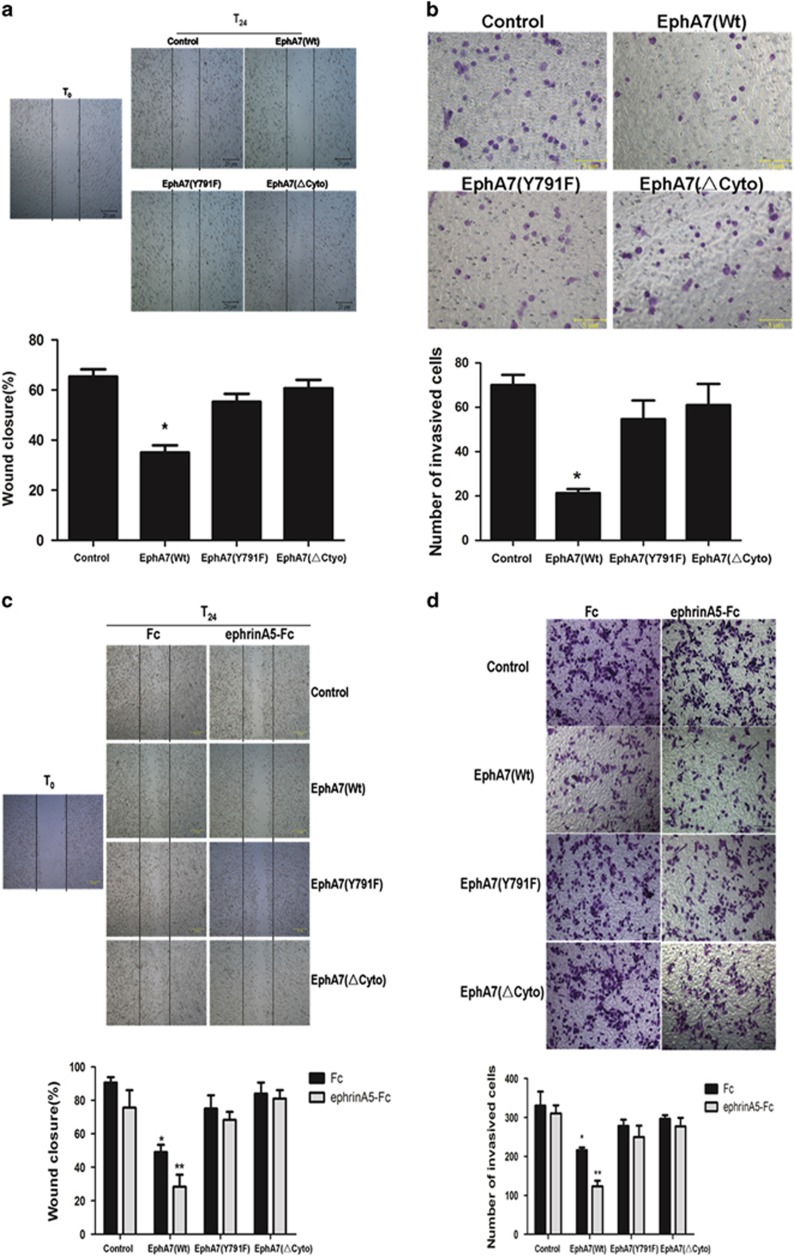
Ligand-dependent inhibition of cell migration and invasion by EphA7 in PCa. (a) DU145 cell migration activity was measured using the wound healing assay. (b) DU145 cell invasion activity was detected with the Matrigel invasion assay (× 100). (c) PC-3 cell migration activity was measured using the wound healing assay. Cells were serum-deprived for 24 h, scratched with a tip and photographed (T0). After stimulation of 1.0 μg/ml of ephrinA5 ligand or Fc for 15 min, cells were cultured in complete medium for 24 h and photographed (T24). (d) PC-3 cell invasion activity was detected with the Matrigel invasion assay (× 100). A total of 5 × 104 cells were plated in transwell inserts, treated with 1.0 μg/ml of ephrinA5 ligand or Fc for 15 min and cultured for 24 h. All experiments were performed in triplicate. Data are shown as the mean±S.D. *P< 0.05 versus the respective control group, **P<0.05 versus the respective EphA7(WT) expression group